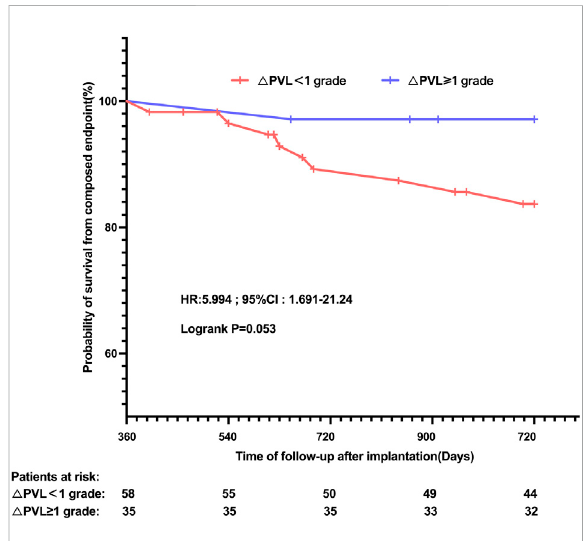
FIGURE 4 Kaplan – Meier estimates of the rate of the primary composite endpoint according to the PVL reduction grade at 1-year follow- up, following TAVR, in patients with at least mild PVL before discharge. PVL: paravalvular